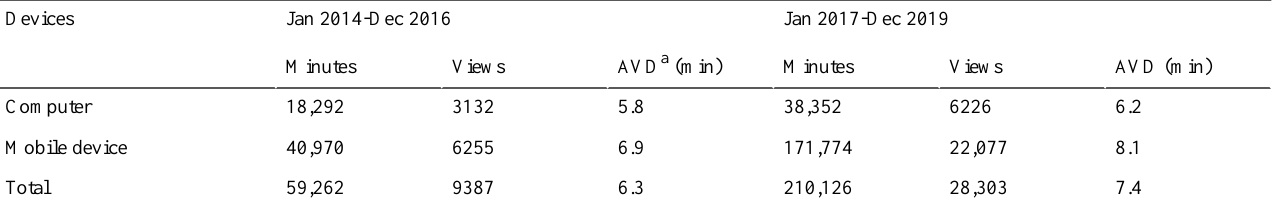
Table 1. Devices used for